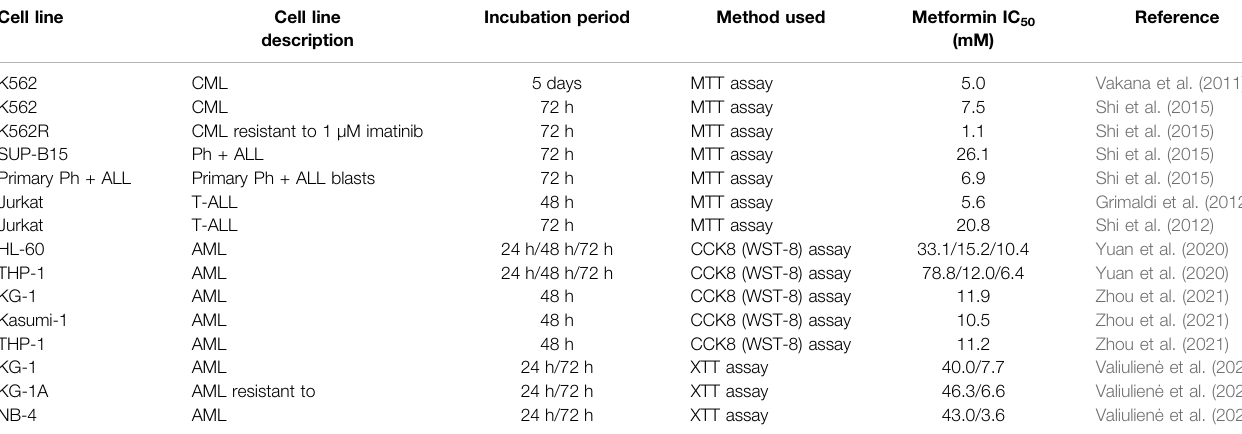
TABLE 3 | Half maximal inhibitory concentration (IC 50 ) values from the literature for metformin in leukemia cell lines. Cell line